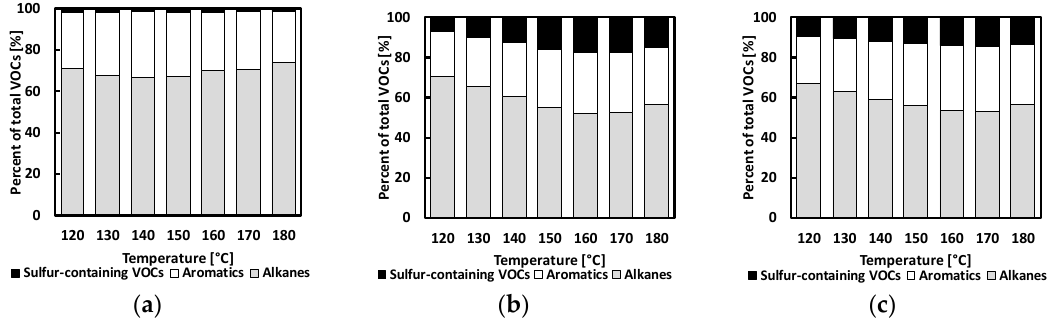
Figure 7. Influence of CR on the percentage of alkanes, aromatics, and sulfur-containing VOC emission with an incremental increase in temperature: ( a ) REF, ( b ) CRMB1, and ( c ) CRMB2.